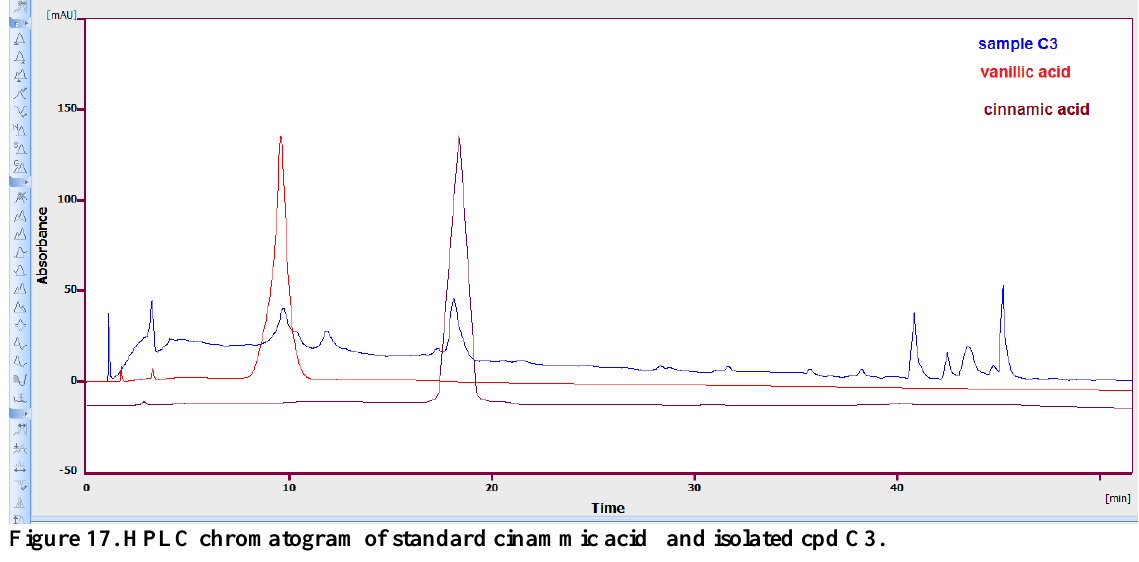
Figure 17. HPLC chromatogram of standard cinammic acide and isolated cpd C3.